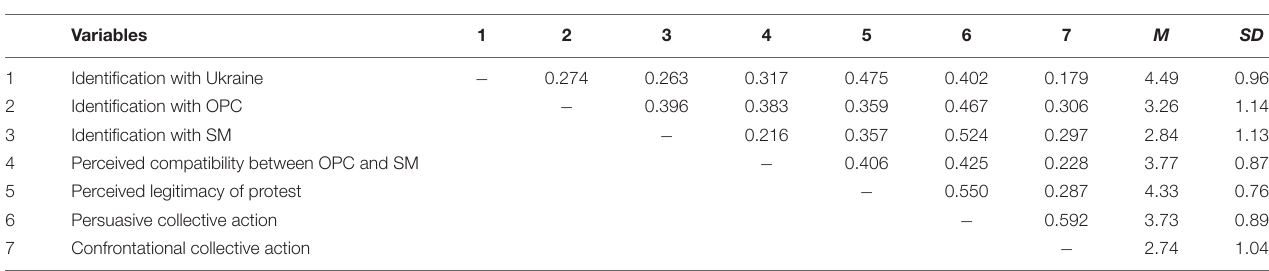
TABLE 1 | Correlations and descriptive statistics for all variables ( N =